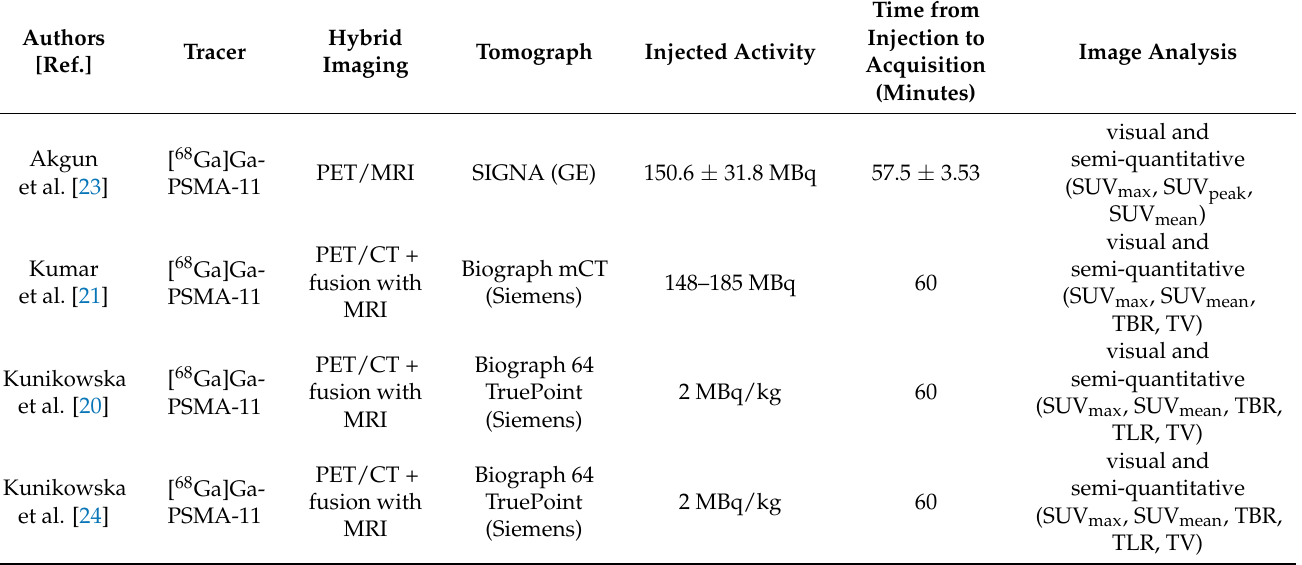
Table 3. Index test key